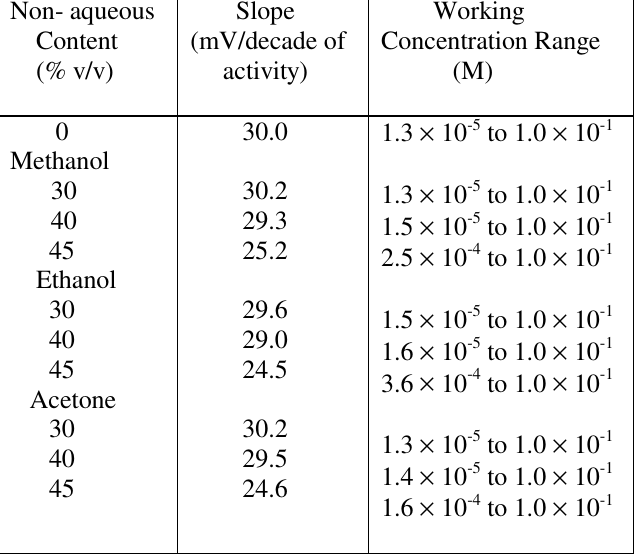
Table 3 : Effect of partially non-aqueous medium on the working of Zn 2+ sensor (Electrode no. 2) Non-